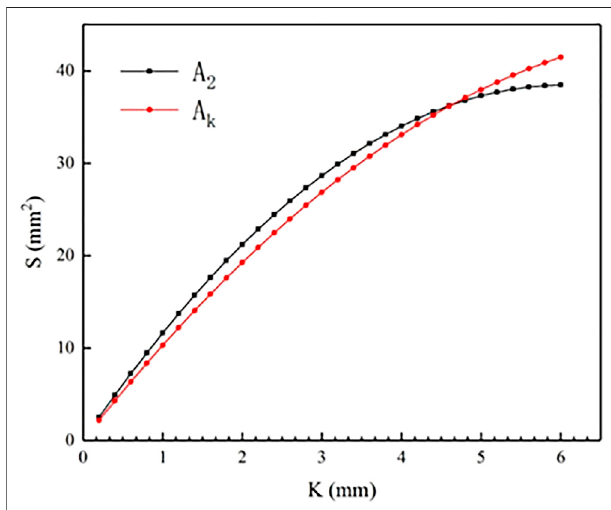
FIGURE 7 | The relationship among the cross-sectional area of the ori fi ce and downstream channel and the opening.